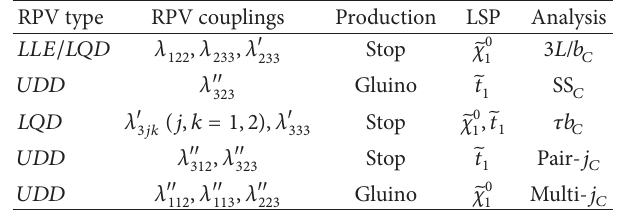
Table 4: Overview of RPV model parameters investigated by CMS analyses. The signature descriptions are also indicated in Table 3 with corresponding